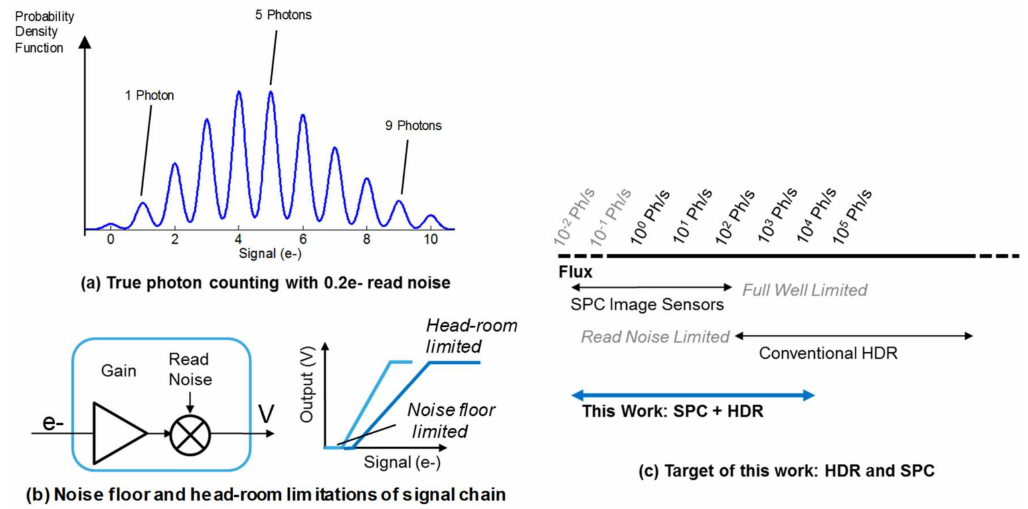
Figure 1. ( a ) Single photon counting is realised in DSERN pixels with <0.30 e − RN. Example is 0.2 e − RN with clearly visible peaks from counted photons during an integration time ( b ) Image sensor analogue signal chains impose both head-room and noise floor limitations on dynamic range ( c ) Target of this work is high dynamic range in a photon counting